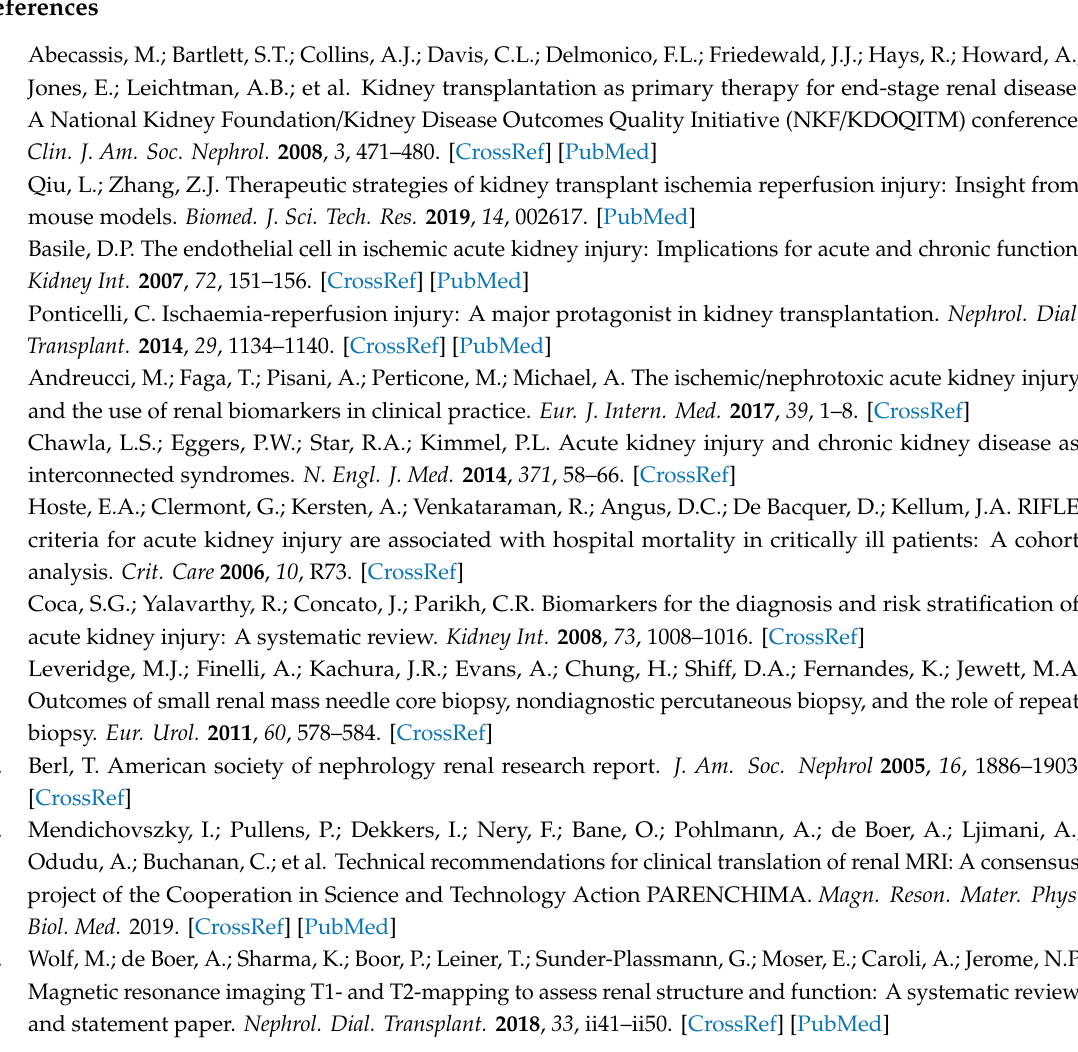
Figure S1: Regions of interest (ROI)